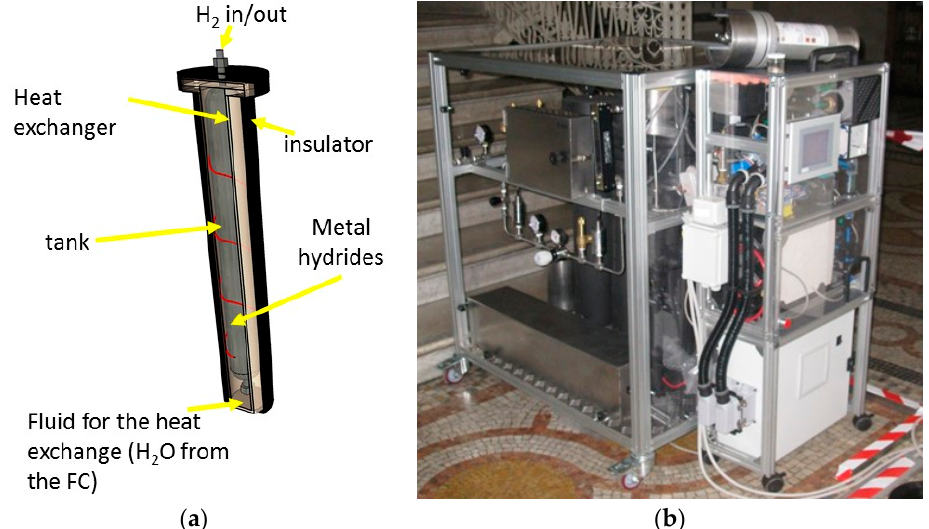
Figure 5. Stationary application of hydrogen storage using LaNi 4.8 Al 0.2 as a carrier. ( a ) Schematic view of the hydrogen tank; ( b ) general view of the developed system. Details available in Rizzi et al. [142].